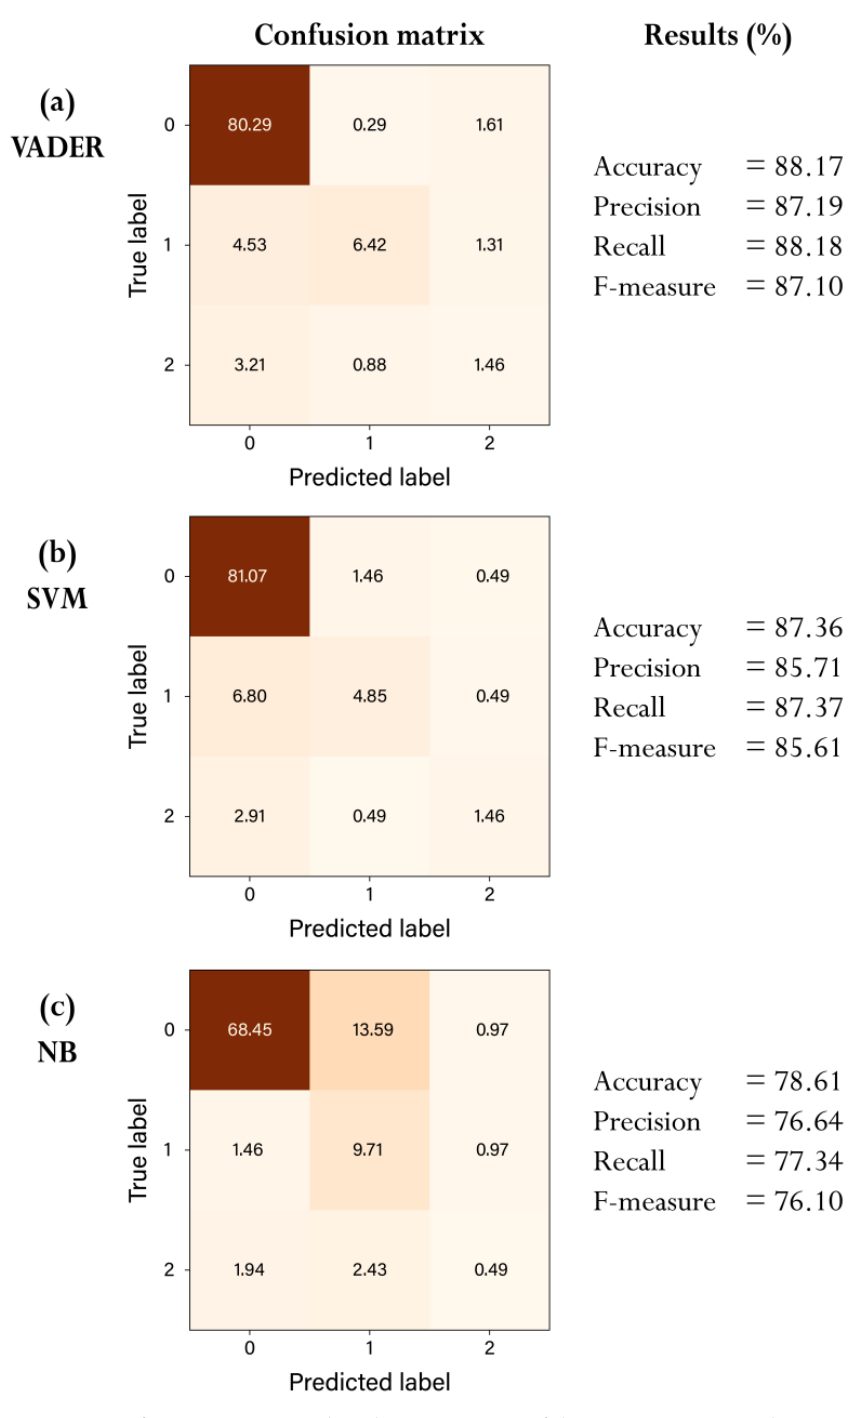
Figure 5. Confusion matrices and evaluation metrics of the VADER, SVM, and NB methods. Figure 5b,c show the representations used to evaluate SVM and NB within the